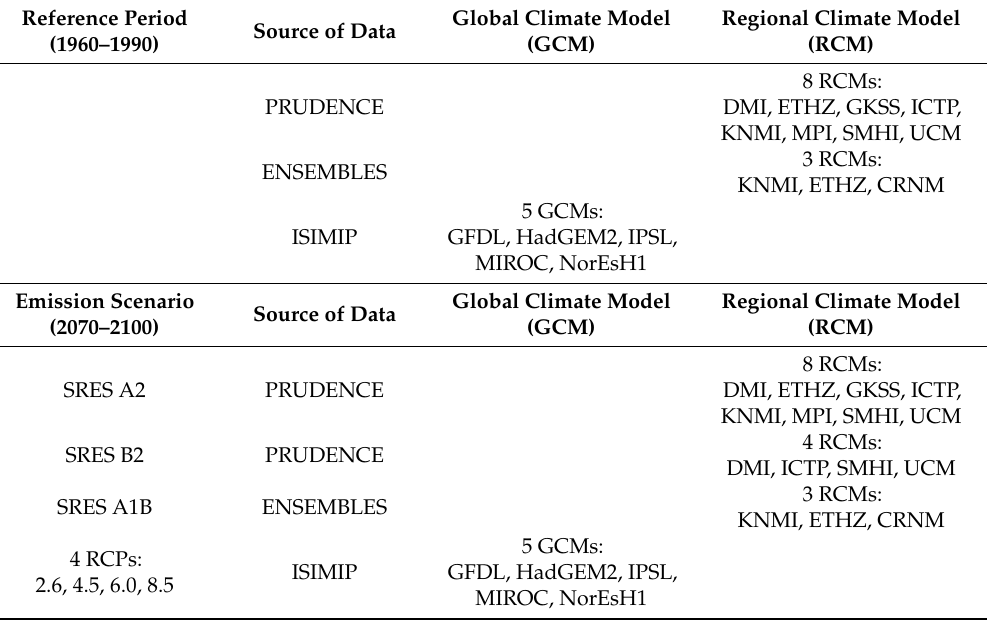
Table 2. Climate simulations considered in this study, all for the reference period (1960 to 1990) and for the future time period